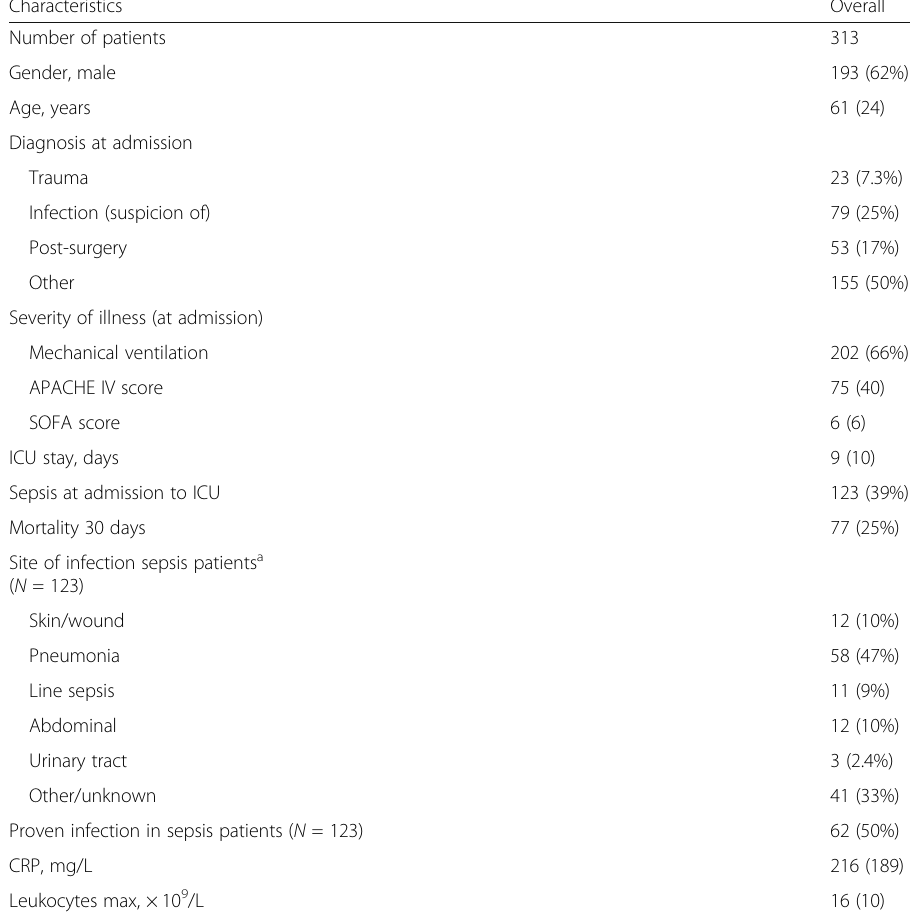
Table 1 Descriptive characteristics, medians (IQR) or N (%) Characteristics Overall Number of patients 313 Gender, male 193